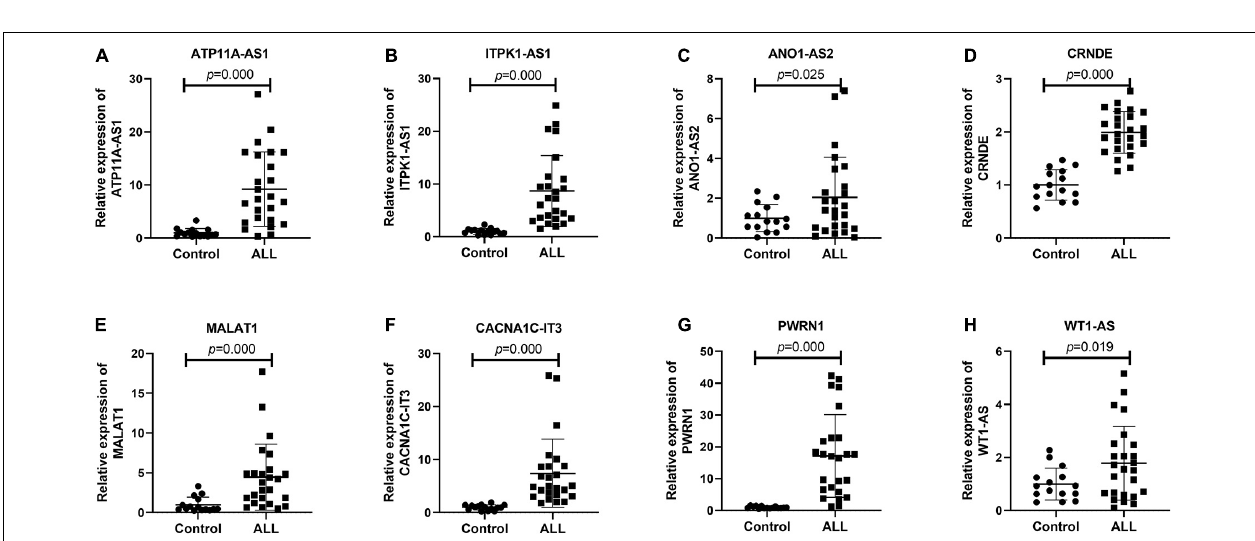
Frontiers in Genetics |